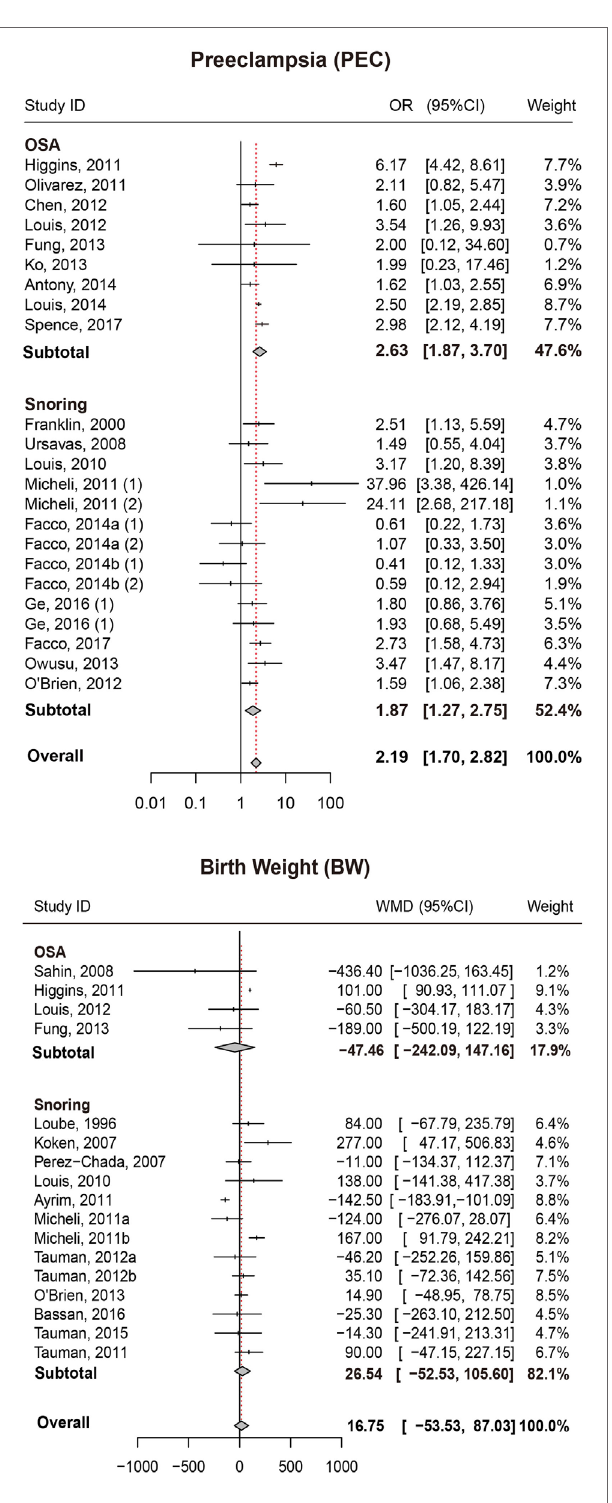
FigURe 3 | Forest plot of the association between PEC/BW and SDB (snoring and OSA). Results are expressed as OR or WMD with 95% CI. PEC, preeclampsia; BW, birth weight; SDB, sleep-disordered breathing; OSA, obstructive sleep apnea; OR, odds ratio; WMD, weighted mean difference; CI, confidence interval. The numbers after authors were used to distinguish different groups within one trial.